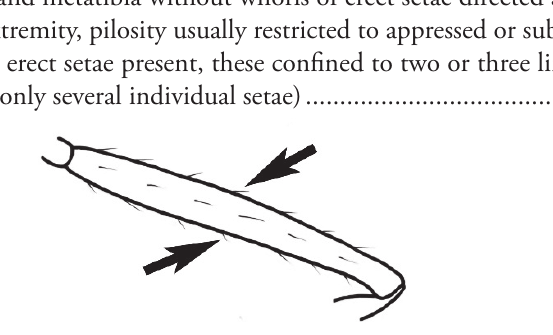
66 Tibiae and antennal scape matt, strongly microreticulate; erect setae on metatibia shorter, stout, length of longest setae < greatest width of tibia; appressed metatibial setae thickly distributed and often forming a distinct pubescence, metatibia matt; gaster of minor worker strongly pubescent (common and widespread) ( JDM 520 ) (Fig. 65a–g) .................